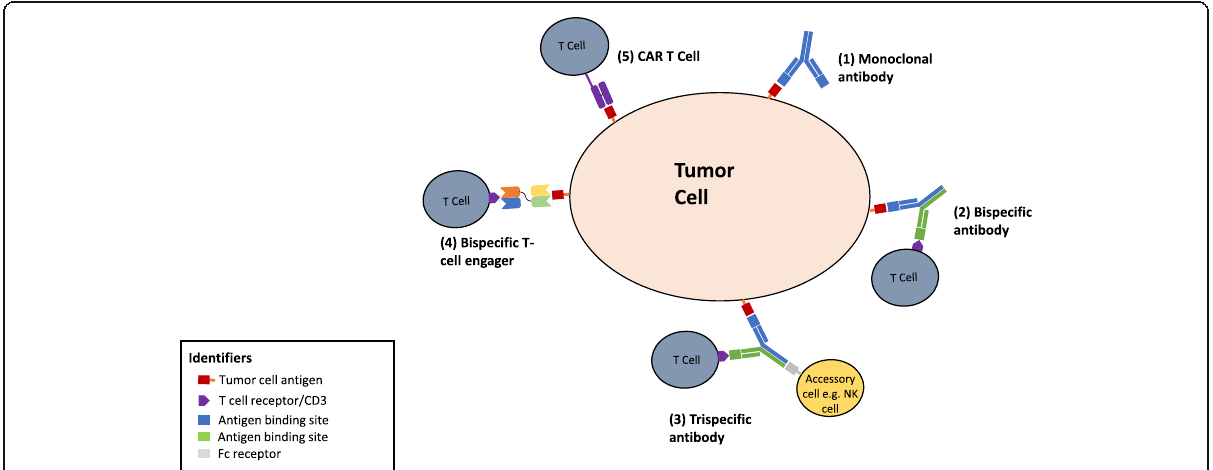
Fig. 2 Schematic showing different formats of immunotherapy binding to the antigen on the tumor cell: (1) monoclonal antibody, (2) bispecific antibody, (3) trispecific antibody, (4) bispecific T cell engager made from two single chain antibody fragments, and (5) CAR T cell therapy which is comprised of light chain and heavy chain variable fragments joined by a flexible linker